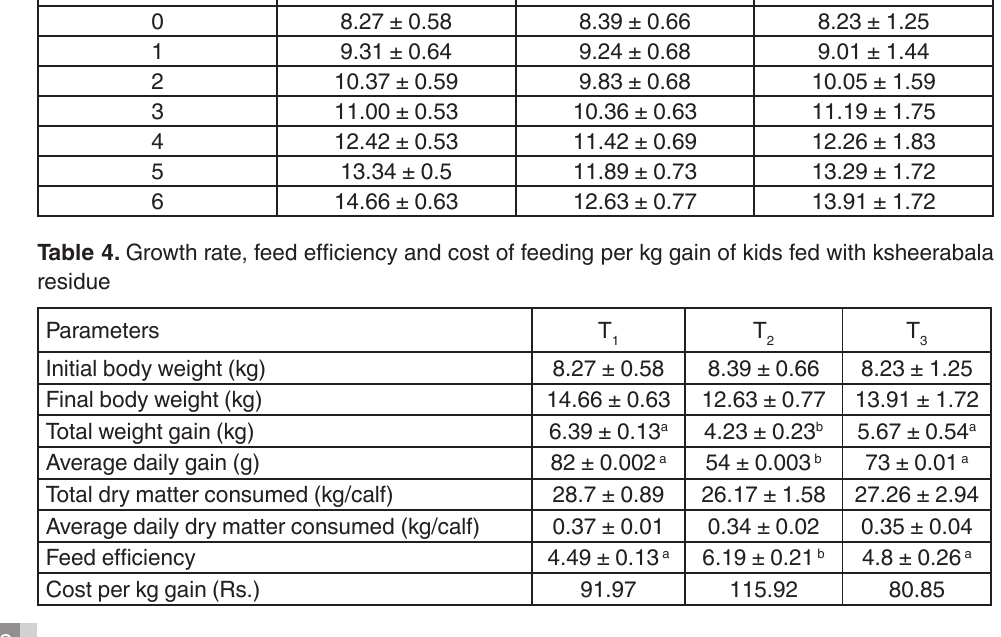
Table 3. Fortnightly average body weight of experimental kids fed diets containing ksheerabala residue Fortnights